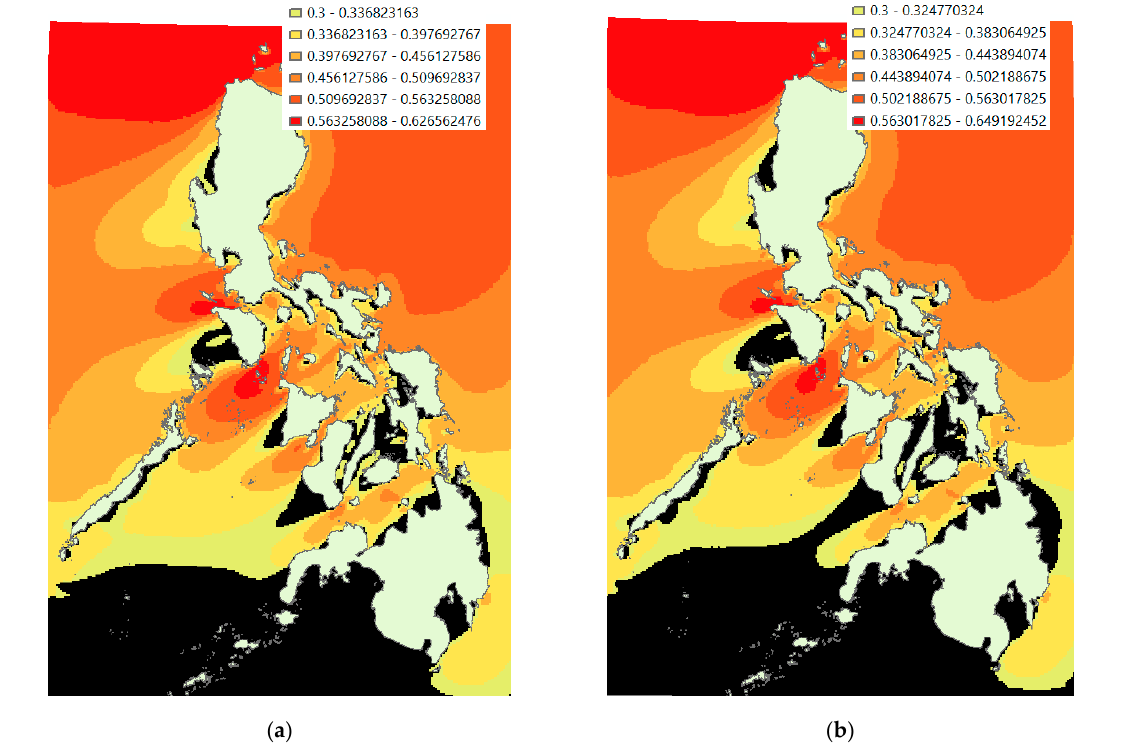
Figure 20. Capacity factor of ( a ) SWT-3.6-120 and ( b ) 6.2M126.